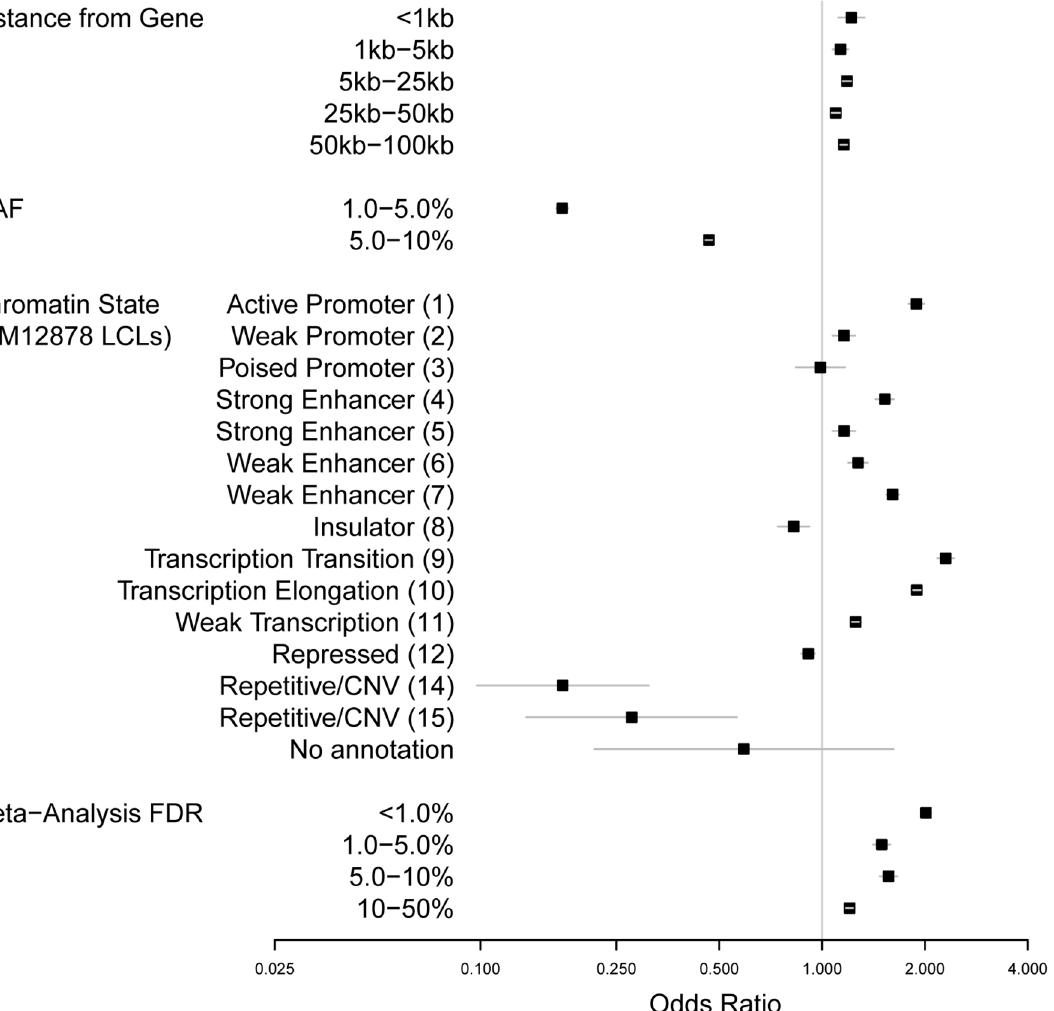
Fig 4. Forest plot of component effects of complete GWAS predictive model based on training set of SNPs. Odds ratios (black squares) from the complete multivariate model ( “ chromstate+eqtl [M3] ” ) for features predicting the membership of a SNP in the NHGRI GWAS Catalog are shown here with standard errors (gray lines). Smaller models are shown for comparison in S2 Fig. Four classes of SNP annotation are represented in the model, each with multiple levels: distance from gene, MAF, chromatin state in GM12878 LCLs (12), and evidence of eQTL association based on meta-analysis FDR. The base levels for each annotation are “ 0 kb (within gene) ” [Distance from Gene], “ > 10% ” [MAF], “ Heterochromatin (13) ” [ChromHMM], and “ > 50% ”